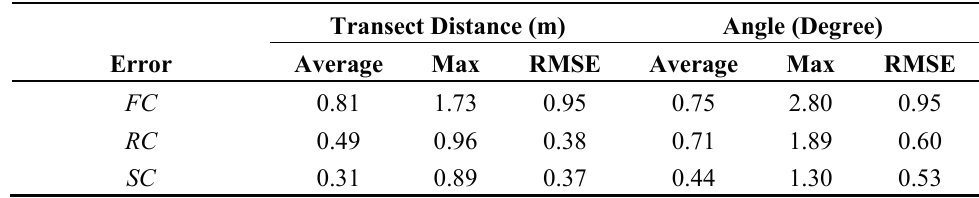
Table 4. Evaluation of the geometric precision of LiDAR data registration using building boundaries.